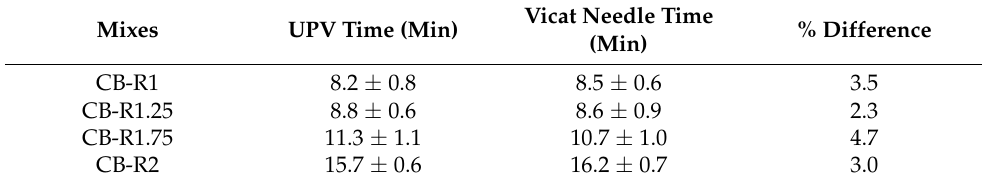
Figure 12. ( a ) Evolution of UPV with time for mix 5. ( b ) Derivative of the UPV graph. Table 2. Setting times for different mixes using the UPV test and Vicat needle